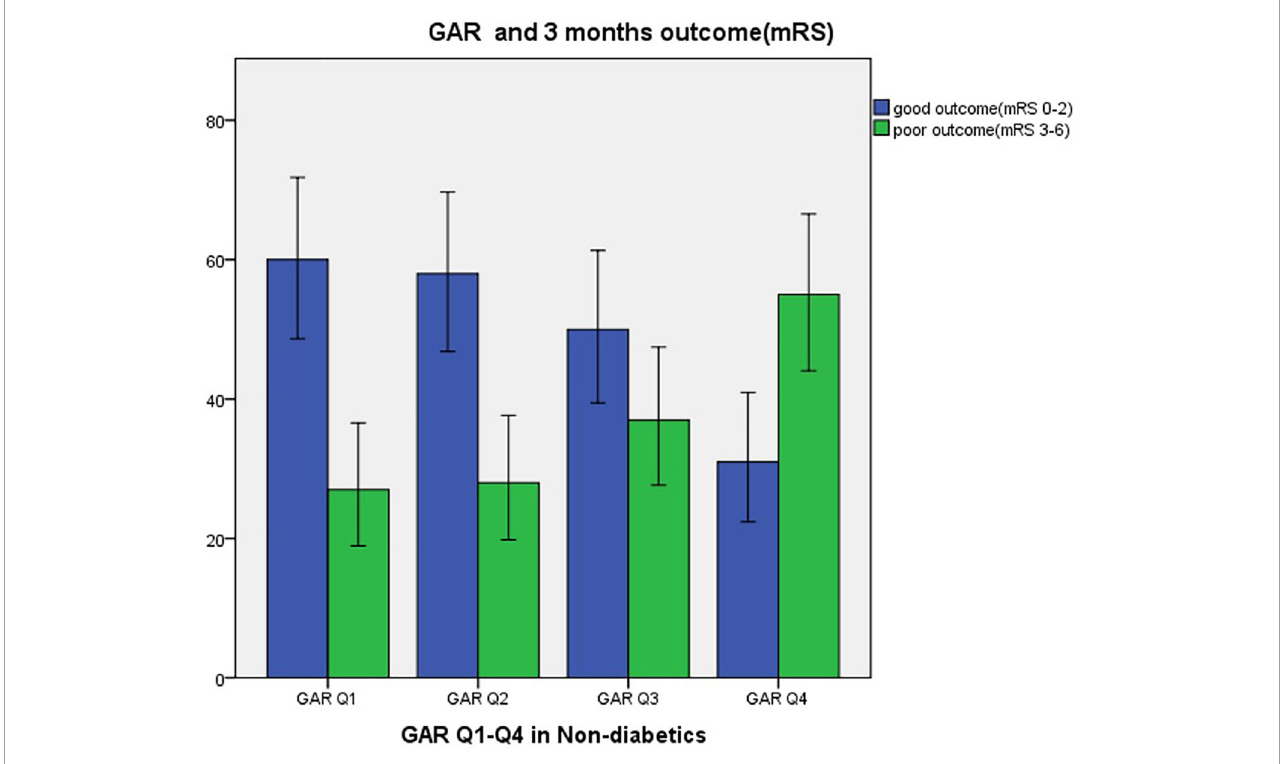
FIGURE3 Three months outcome by GAR quartile in non-diabetic patients. GAR Q1, first glucose-to-glycated hemoglobin ratio quartile; GAR Q2, second glucose-to-glycated hemoglobin ratio quartile; GAR Q3, third glucose-to-glycated hemoglobin ratio quartile; GAR Q4, fourth glucose-to-glycated hemoglobin ratio